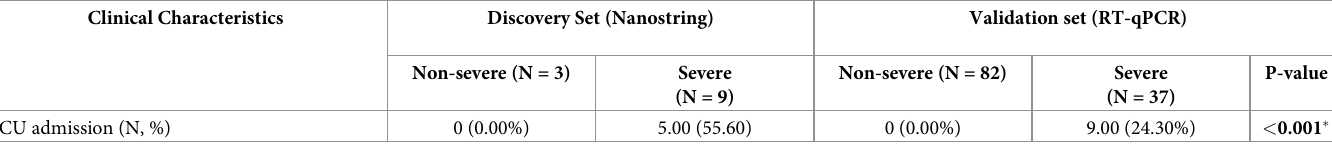
The result showed that total mSOFA score had a positive correlation with both miR155-5p (r = 0.236, p = 0.010), and miR630 (r = 0.236, p = 0.010). Also among patients with severe lepto- spirosis, total mSOFA were correlated with both miR155-5p (r = 0.493, p = 0.002) and miR630 (r = 0.508, p = 0.001). The relationship between serum miRNAs levels and length of hospital stay was also examined. Among patients with severe leptospirosis, both miR155-5p (r = 0.521, p = 0.005) and miR630 (r = 0.522, p = 0.005) was correlated with length of hospital stay. In terms of determining correlations between serum miRNA levels and other markers of inflammation. Levels of IL-6 were measured in plasma from 32 leptospirosis participants (18 non-severe and 14 severe leptospirosis). The result showed that the IL-6 levels were correlated with both miR155-5p (r = 0.586, p < 0.000) and miR630 (r = 0.559, p = 0.001). Serum miRNAs associated with severity and mortality of leptospirosis The ROC curve for miR155-5p and miR630 were generated on the same graph to compare their diagnostic accuracies. As shown in Fig 3A, the area under the ROC curve (AUROC) of